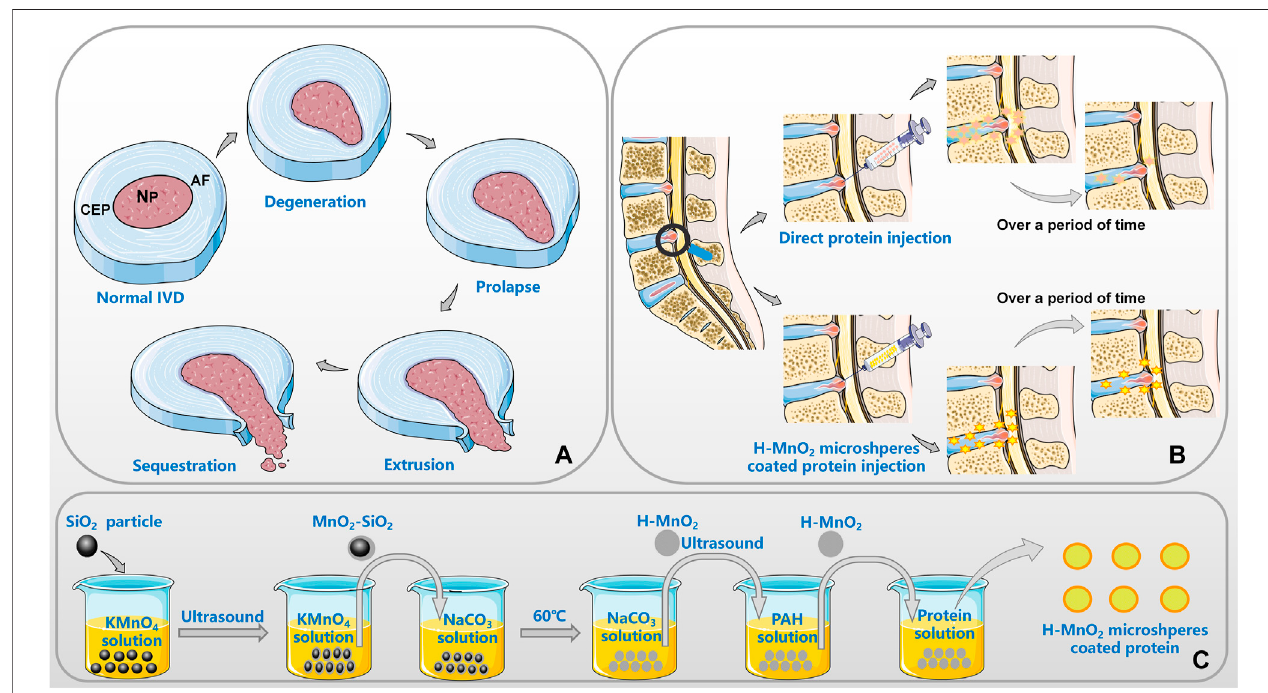
FIGURE1| Application ofMnO 2 microspheresinDDD[ (A) .thepathologicalprogress ofIVD; (B) .theadvantagesofMnO 2 asacarrier; (C) .thegeneralpreparation process of the h-MnO 2 protein delivery].